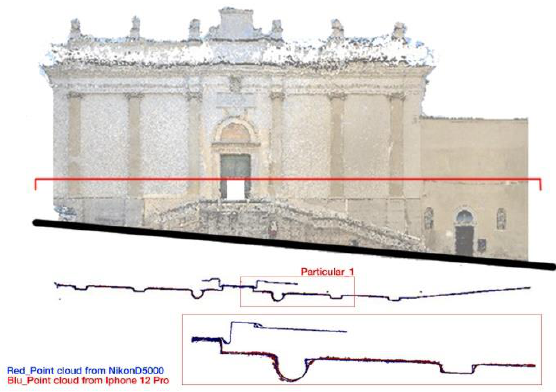
Figure 8. Detailed analysis: point cloud comparison from Nikon D5000 camera (in blue) and from iPhone 12 PRO (in red).